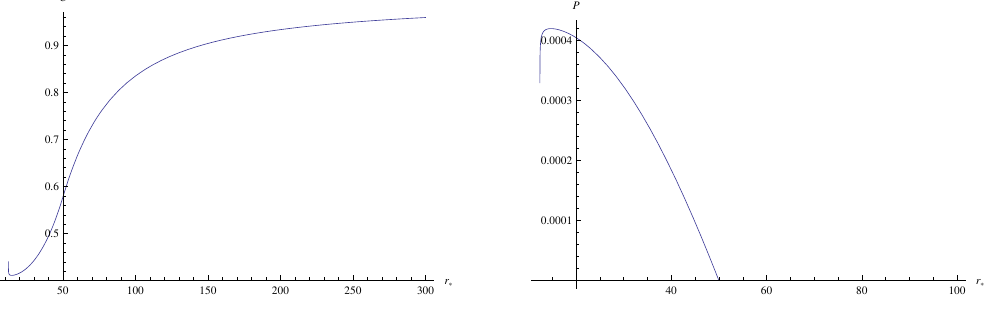
Figure 15 . The factor C (left) and the pressure P (right) for (cid:20)m 0 ’ (cid:20)m (cid:3) ’ 0 : 00227 with the surface radius r (cid:3) s = 50 where r s ’ 23 : 65. Figure 15 is a plot of C and P for (cid:20)m = 0 : 00227. The radius r for (cid:20)m 0 that for (cid:20)m = 0 : 00226 are depicted in (cid:12)gure 16. The limit of the numerical 0